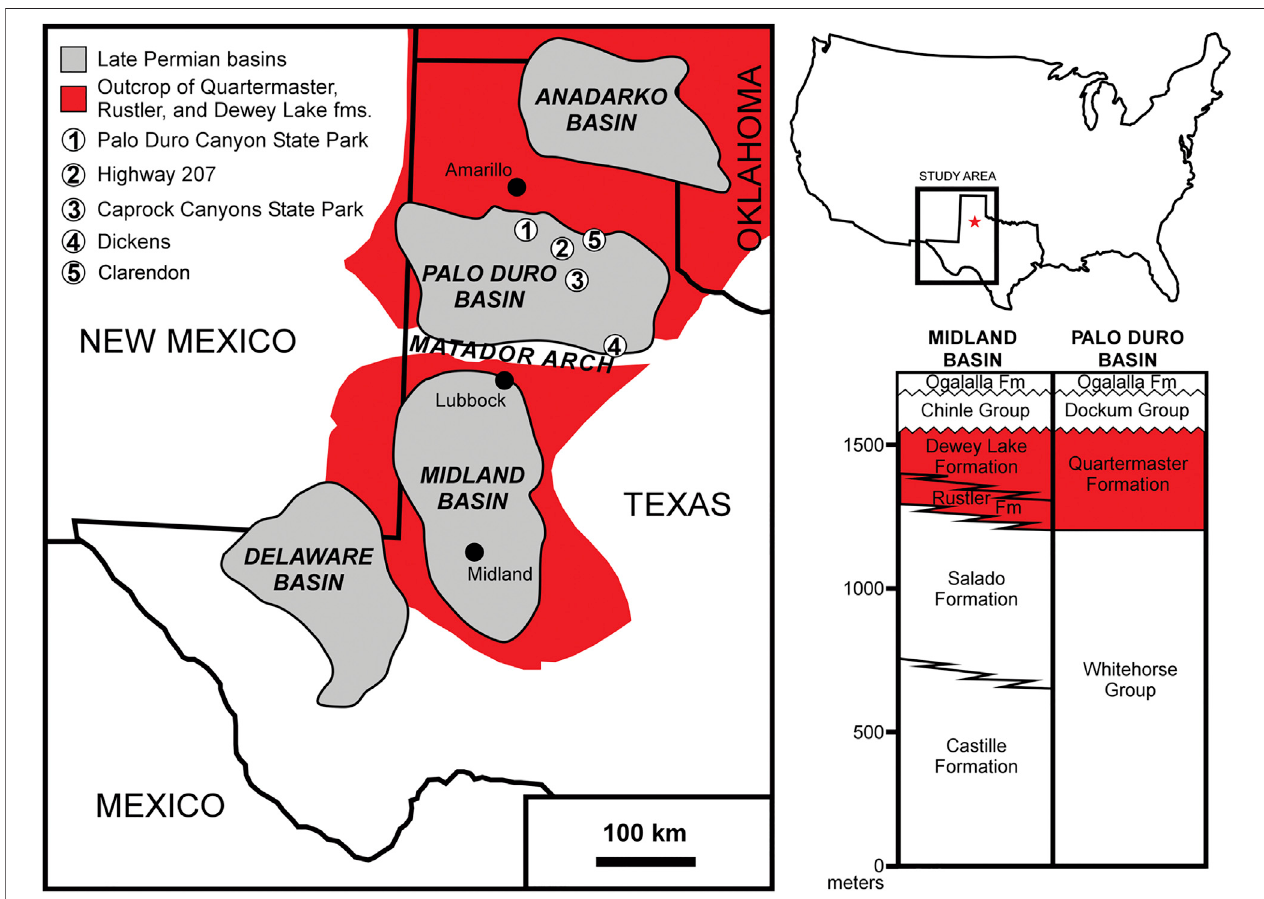
FIGURE 1 | Location map of study area and generalized stratigraphy for the uppermost Permian to lowermost Triassic strata studied. Gray regions represent Late Permian basins that accommodated upper Permian strata in Oklahoma, west Texas and eastern New Mexico whereas the red areas represent the extent of outcrop of uppermost Permian to lowermost Triassic strata, including the Quartermaster, Rustler and Dewey Lake formations. Major cities are located by the position of black circles. White circles with numerals in them locate the different outcrop exposures examined in this study: 1 (cid:1) Palo Duro Canyons State Park, 2 (cid:1) Highway 207 roadside outcrop, 3 (cid:1) Caprock Canyons State Park, 4 (cid:1) Dickens roadside outcrop (State Highway 114/82), 5 (cid:1) Clarendon. Permian exposures associated within the Palo Duro Basin include the upper part of the Whitehorse Group and the Quartermaster Formation, both of which were previously thought to be “ Ochoan ” in age and which are unconformably overlain by Norian-age (Upper Triassic) strata of the Dockum Group. See text for discussion.